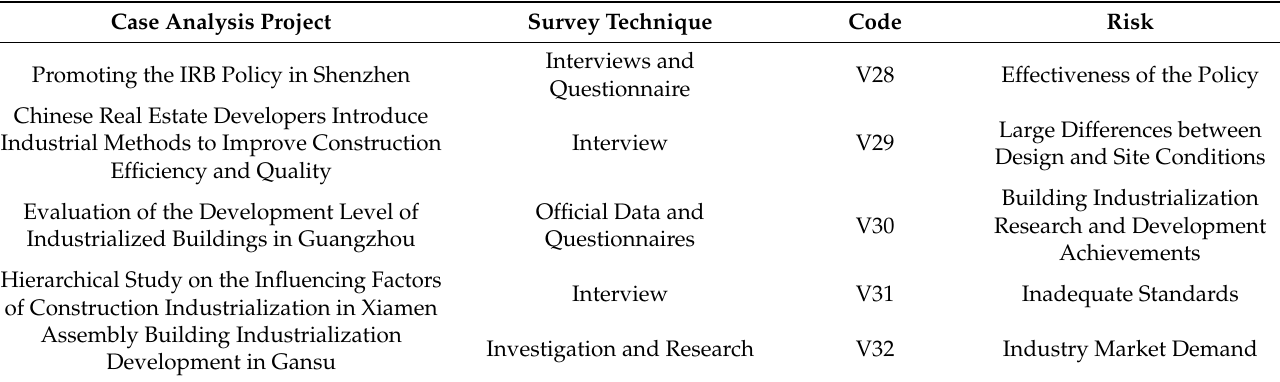
Table 2. Risk investigation approach and risk triggers for five case